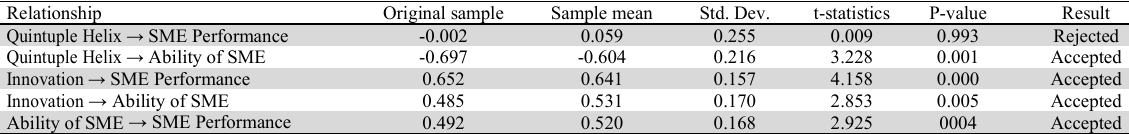
Result of bootstrapping Spain craft sub sector